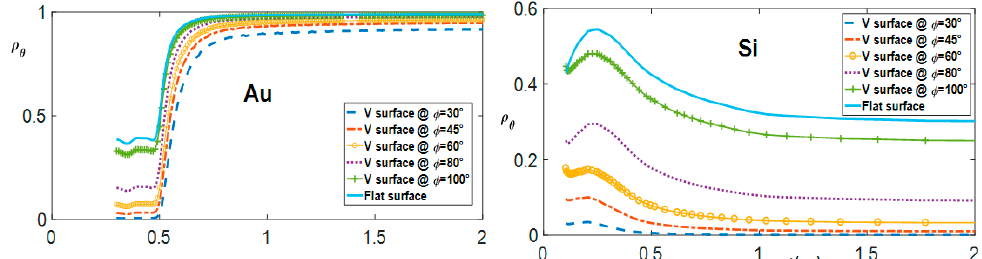
Figure 13. Spectral reflectivity of V-cavity at different aperture angles ( φ = 30 ◦ , 45 ◦ , 60 ◦ , 80 ◦ , 100 ◦ ) and flat surface, formed for the two chosen materials (Au and Si) in the normal direction ( θ = 0 ◦ ).